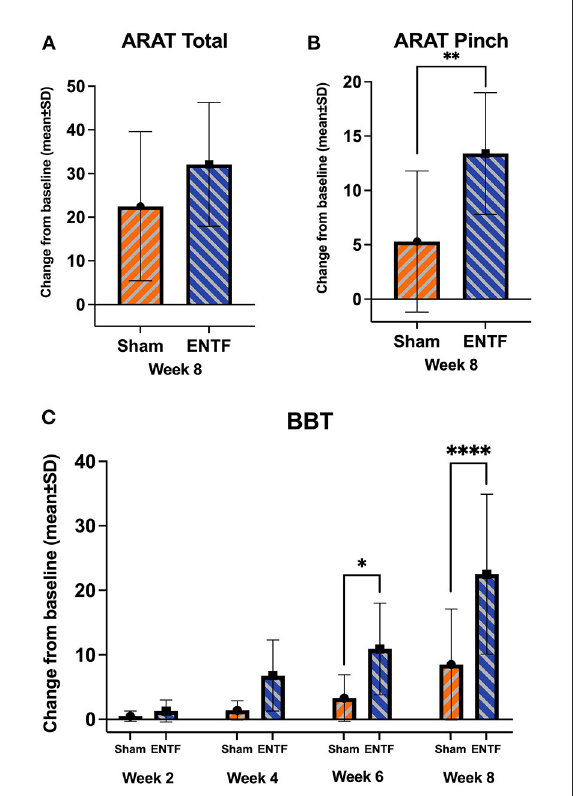
FIGURE3 Evolution of upper extremity function secondary efficacy outcomes (sample mean; error bars correspond to SD; significance based on difference in LSmeans). (A) Action Research Arm Test (ARAT) total score from baseline to week 8 (absolute score change: ENTF group 32.1 ± 14.2 vs. sham group 22.5 ± 17.1, p = 0.09). (B) ARAT Pinch subscale score from baseline to week 8 (absolute score change: ENTF 13.4 ± 5.6 vs. sham 5.3 ± 6.5, p = 0.008; ** p < 0.01). (C) Box and Blocks Test (BBT) affected hand scores from baseline through weeks 2, 4, 6 (absolute change score: ENTF 10.9 ± 7.1 vs. sham 3.3 ± 3.6, p = 0.02; * p < 0.05) and 8 (absolute change score: 22.5 ± 12.4 vs. 8.5 ± 8.6, p < 0.0001; **** p <